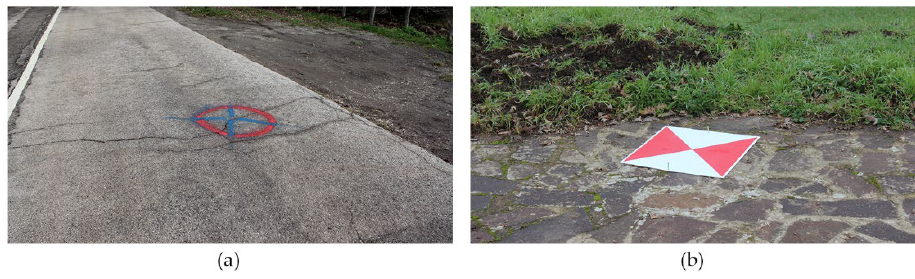
Figure 3. ( a ) Fixed and ( b ) mobile markers.